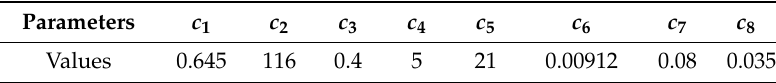
Table 1. Values of parameters c 1 – c 8